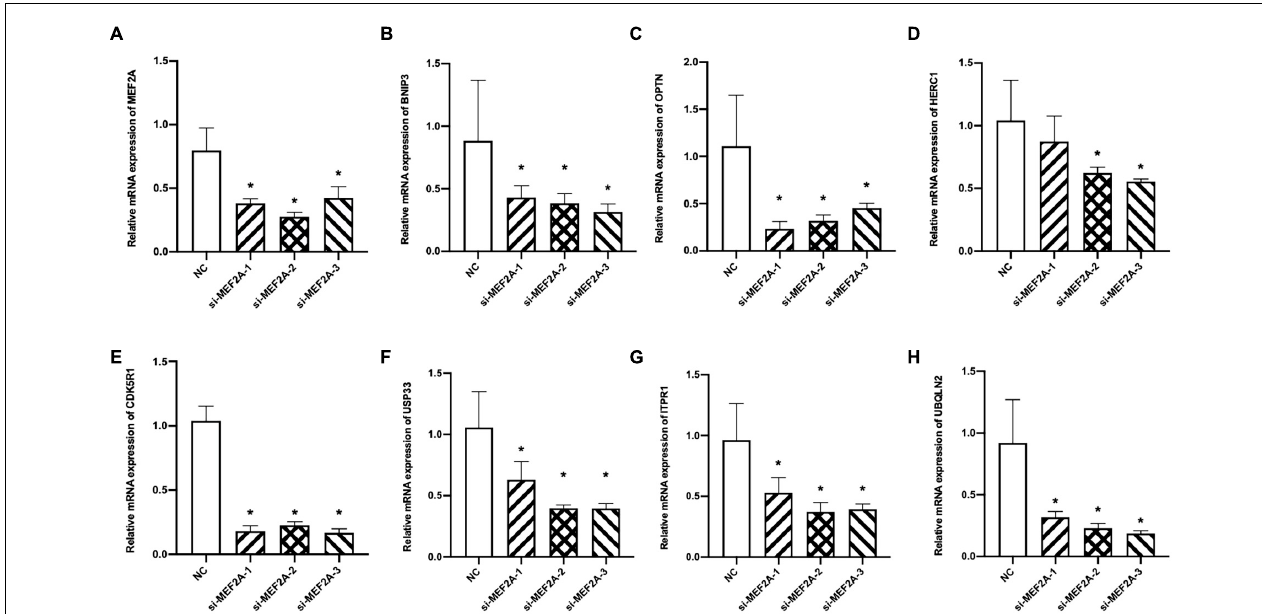
FIGURE 4 | Expression levels of the screened seven genes after si-MEF2A transfection. (A–H) After BV2 cells transfected with three si-MEF2A for 48 h to knock down the expression of MEF2A, the expression levels of MEF2A, BNIP3, CDK5R1, HERC1, ITPR1, OPTN, UBQLN2, and USP33 were detected using qPCR. ANOVA followed by LSD test was used for comparison among groups. * p < 0.05 compared with the control